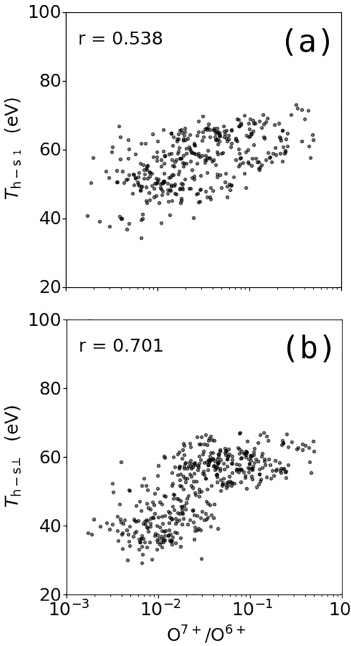
Figure 4. Scatter plots of (a) T h–s1 and (b) T h–s ⊥ against O 7 + / O 6 + for Carrington rotation 2067. Pearson linear correlation coefficients are printed on the plots. Both have moderate and posi- tive values of r , with T h–s ⊥ having a slightly stronger